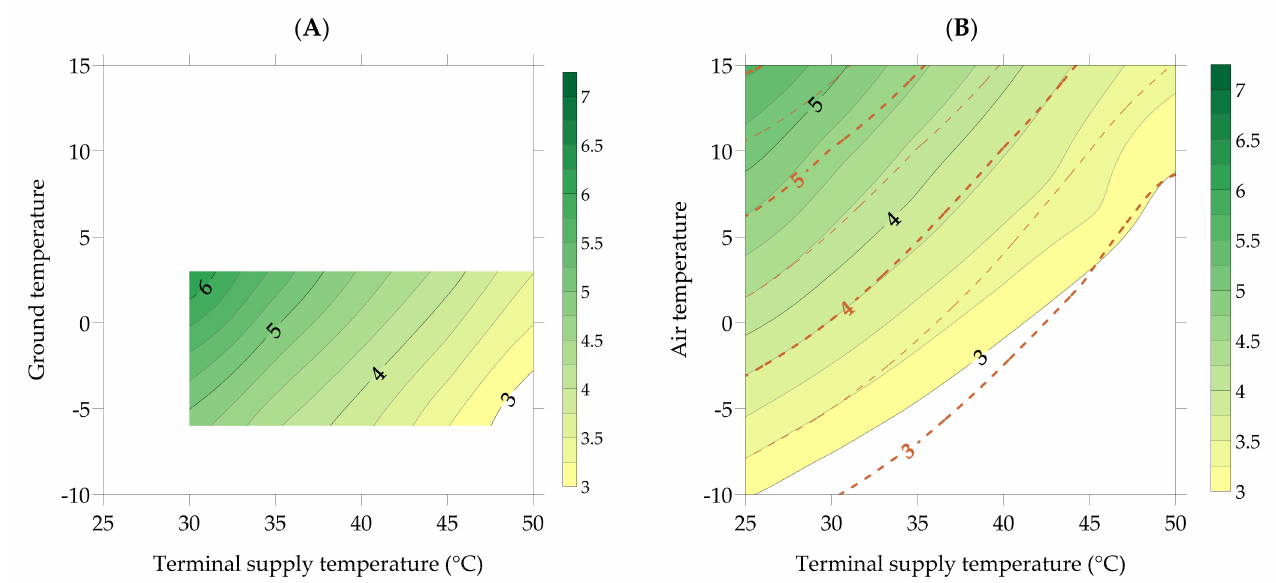
Figure 4. Examples of COP maps of heat pumps (own elaboration with data from [60]): ( A ) GSHP, nominal power 40.3 kW; ( B ) ASHP, nominal power 78.6 kW at full power (black full lines + gradient map) and at 50% power (orange dot